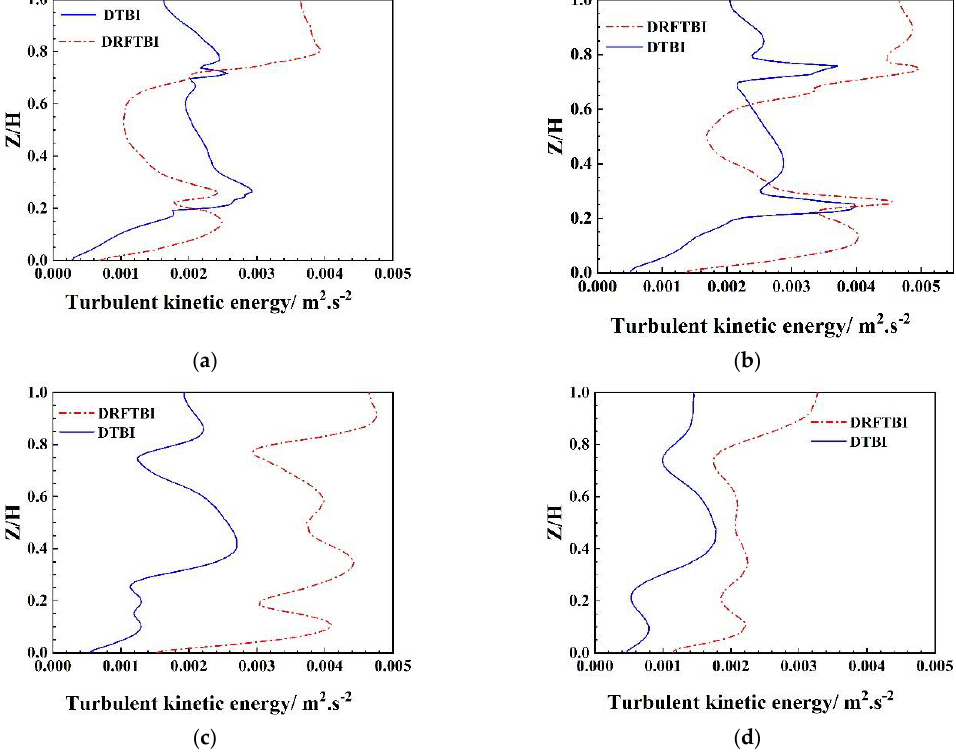
Figure 12. Comparation of turbulent kinetic energy profiles between two systems. ( a ) y 1 ; ( b ) y 2 ; ( c ) y 3 ; ( d ) y 4 . (Rotational speed: 120 rpm; solid loading: 30%; connection strap length: 1.2 Hs.)